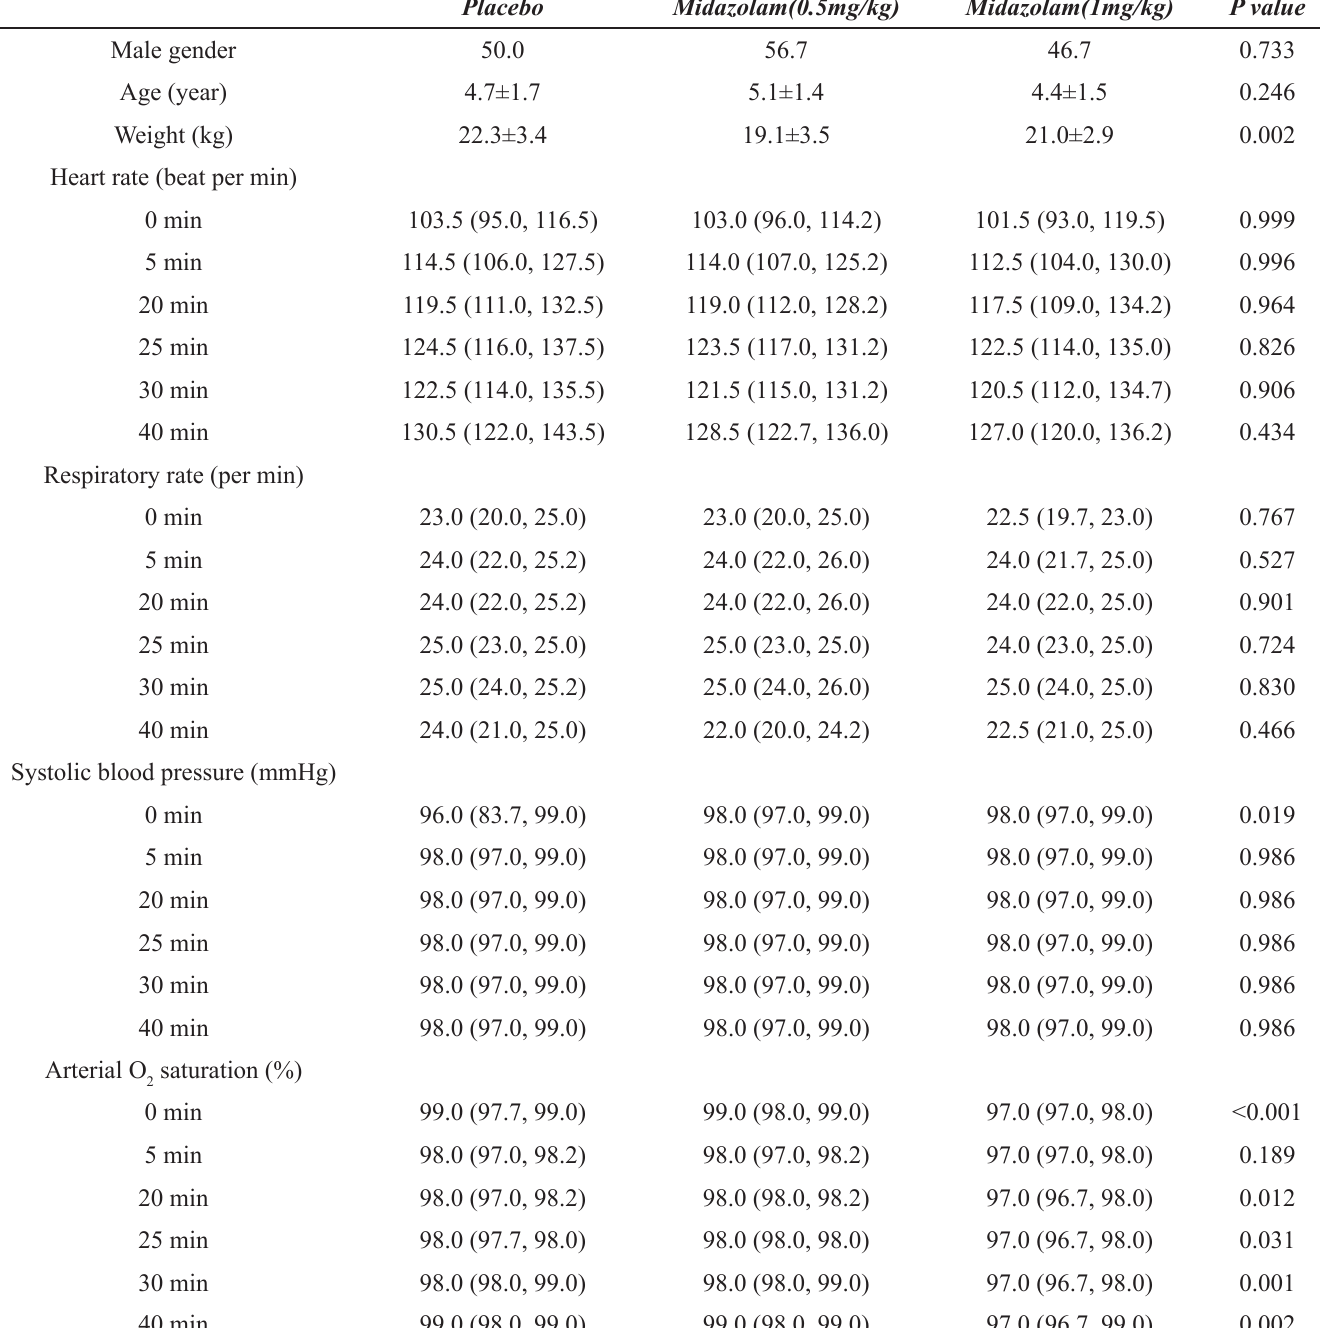
TABLE 2 - Demographic and hemodynamic data of children allocated to receive midazolam or